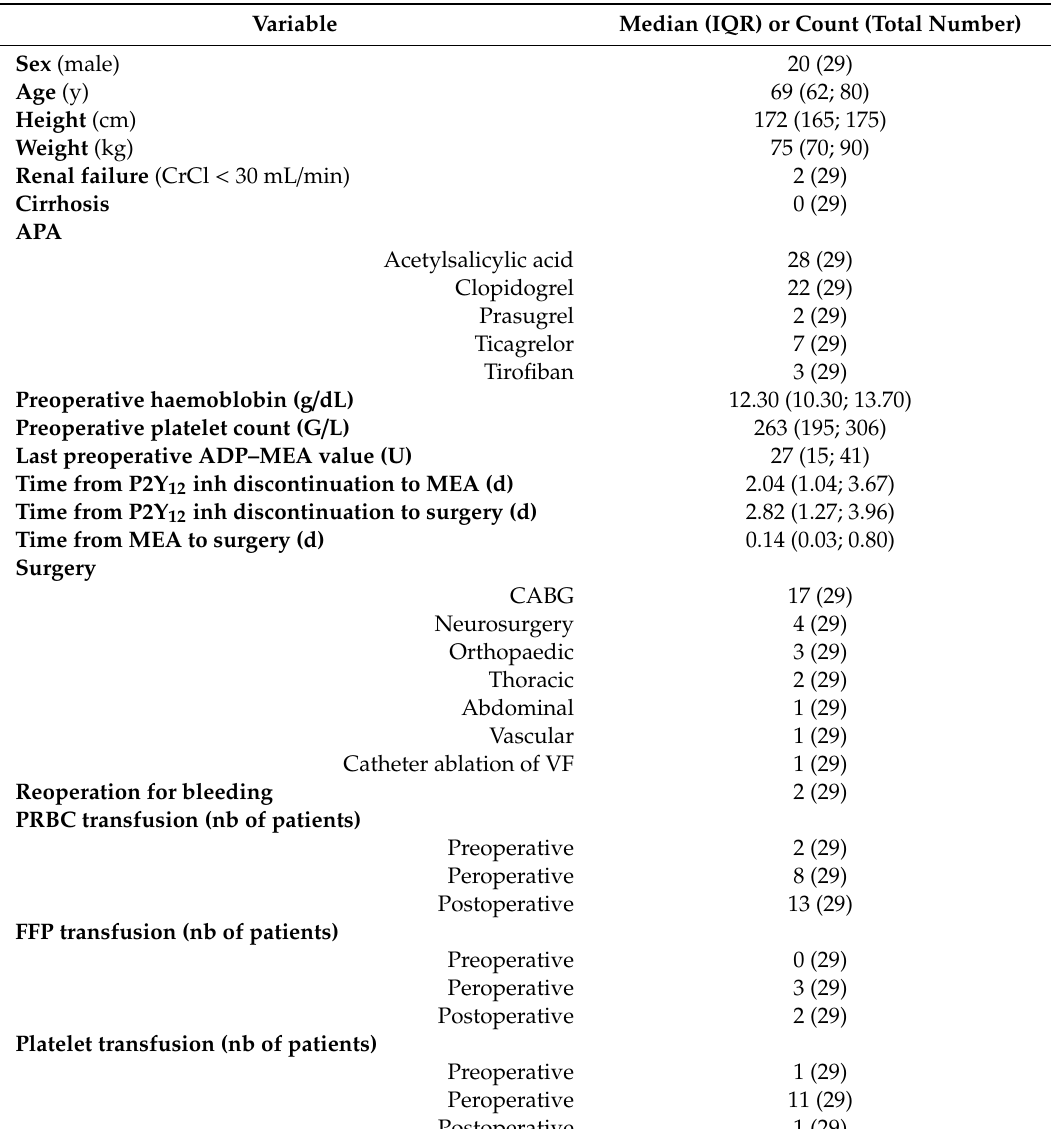
Table 1. Patients characteristics ( n =